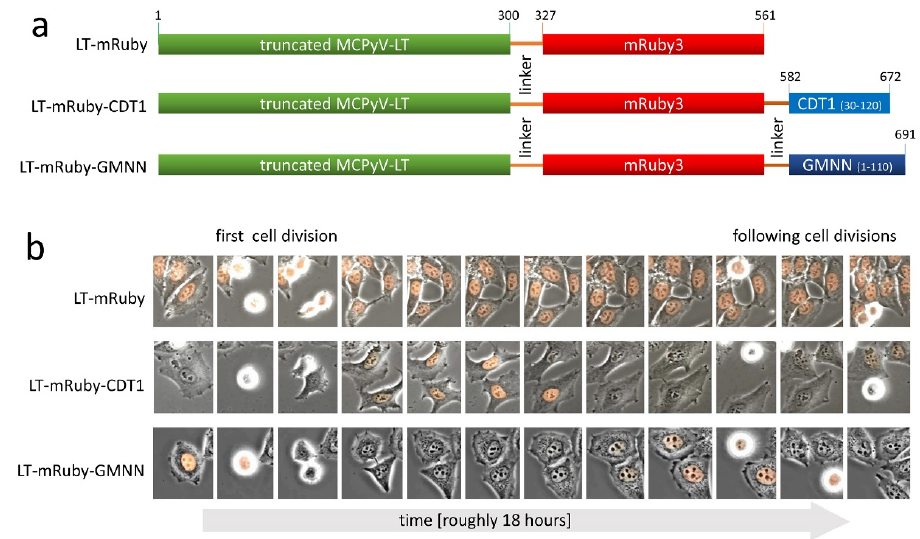
Figure 1. Merkel cell polyomavirus (MCPyV)- Large T antigen (LT) fusion proteins expressed in different phases of the cell cycle. ( a ) Schematic illustration of different Large T proteins analyzed in this study. To make SV40 Large T antigen (LT) detectable by flow cytometry and fluorescence microscopy, the red fluorescent protein mRuby3 was fused to the C-terminus of a truncated MCPyV-LT. To achieve cell cycle-dependent expression, either amino acids 30–120 of CDT1 or amino acids 1–110 of GMNN (also known as Geminin) were added at the C-terminus. ( b ) HeLa cells were stably transduced with retroviral vector pIH encoding the indicated LT variants depicted in ( a ). Time lapse fluorescence microscopy was performed, and the presence of mRuby fluorescence in the course of time is depicted.